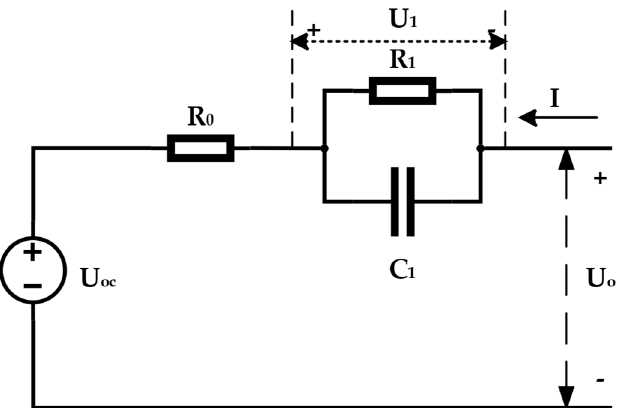
Figure 1. Equivalent circuit model of LIBs ( Remark: If the order of ECM changes, the algorithm can be applied to different ECMs after changing Equations (1)–(7), which are the input − output equations of the system).